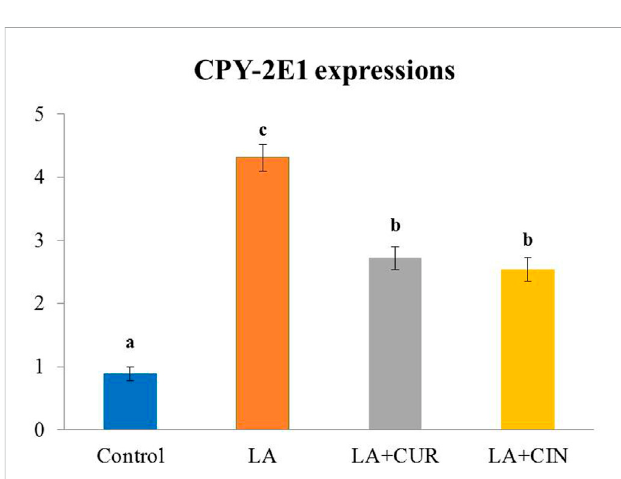
FIGURE 7 Splenic expression of CYP 2E1 in different treatment groups compared with ß -actin (mean±SE).Differentsuperscripts (A – C) ineach fi gure indicate signi fi cant differences at p <